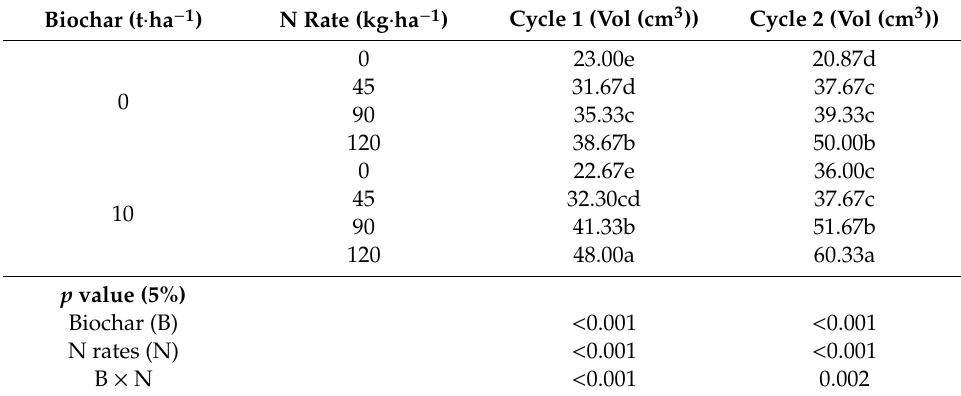
Table 5. E ff ect of soil amendment on root volume (cm 3 ) at flowering stages of rice in the 1st and 2nd cropping